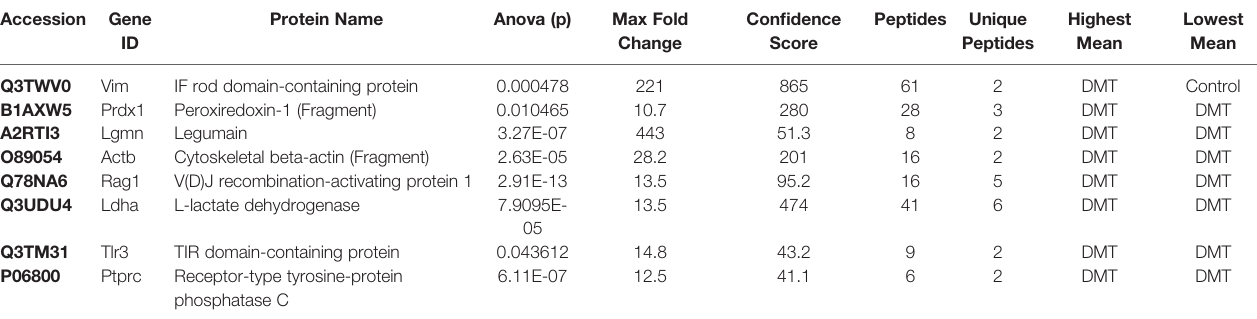
TABLE 9 | Properties of the identi fi ed allergenic proteins following direct microglia treatment (DMT) on the neuroblastoma cell line.